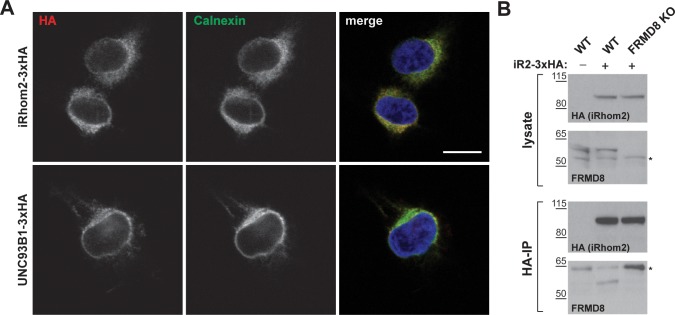
Setup and confirmation of the mass spectrometry screen.(A) HEK293T cells transiently transfected with human iRhom2-3xHA or UNC93B1-3xHA were stained with DAPI (blue) to label nuclei, anti-HA to label iRhom2-HA (red), and anti-calnexin to label the ER (green). Scale bar = 10 μm. (B) Lysates and anti-HA immunoprecipitation (HA-IP) from wild-type (WT) and FRMD8 knockout (KO) HEK293T cells stably expressing iRhom2-3xHA (where indicated) were immunoblotted for HA and FRMD8. Nonspecific bands are marked with an asterisk.